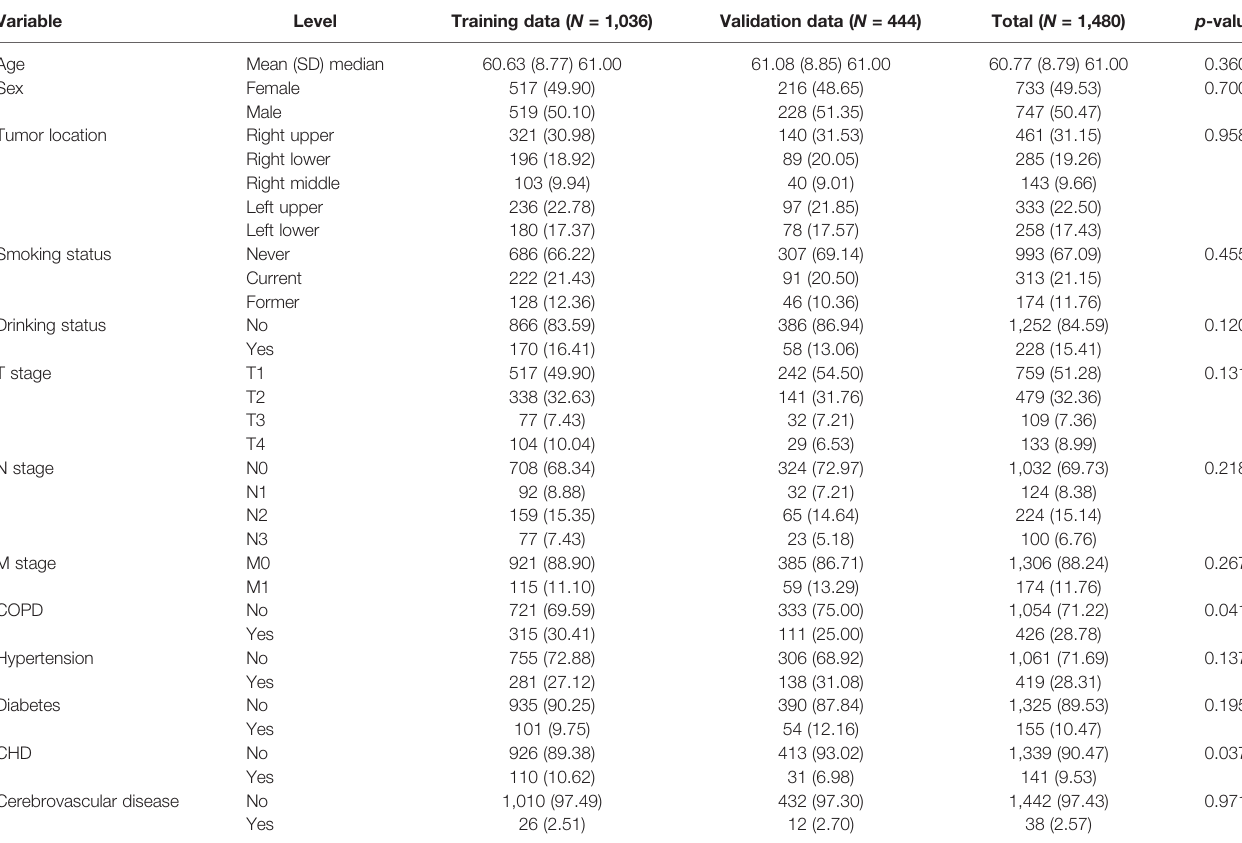
TABLE 1 | Baseline demographic and clinical characteristics in the study. Variable